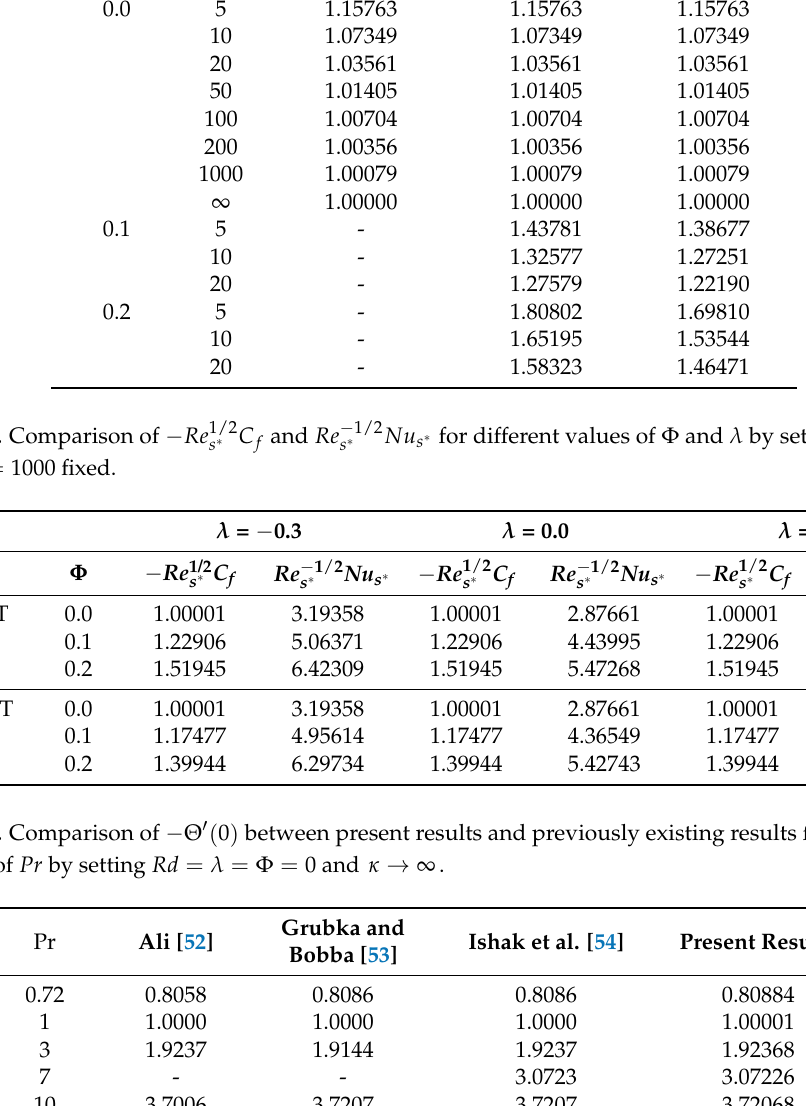
C f between present results and previously existing results of Abbas et al. [44] Table 3. Comparison of − Re 1/2 s ∗ for various values of Φ and κ .